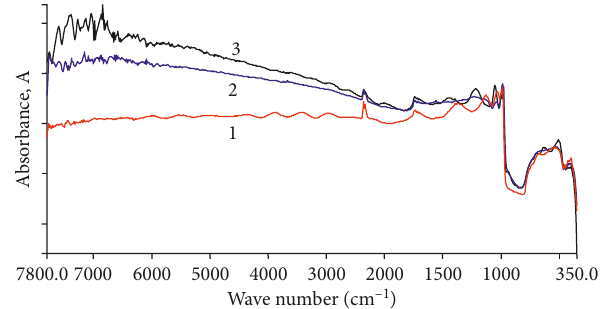
Figure 2: Spectral dependence of optical absorption in the IR region: 1, initial 4 H -SiC crystal; 2, spectrum taken with Al-doped side; 3, spectrum taken from the reverse side of the